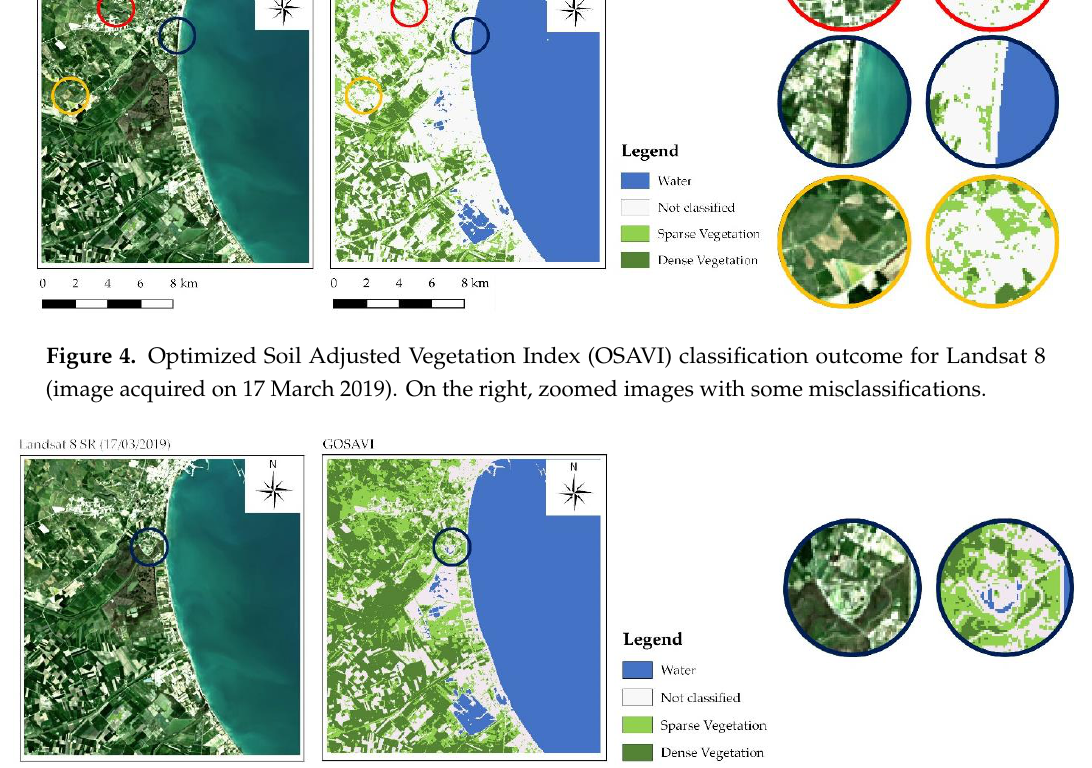
Figure 4. Optimized Soil Adjusted Vegetation Index (OSAVI) classification outcome for Landsat 8 (image acquired on 17 March 2019). On the right, zoomed images with some misclassifications.